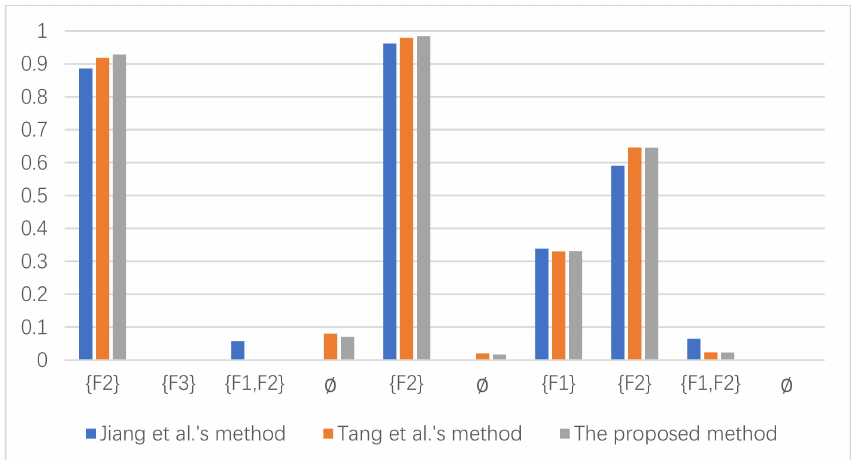
Figure 3. Data fusion results of different methods in fault